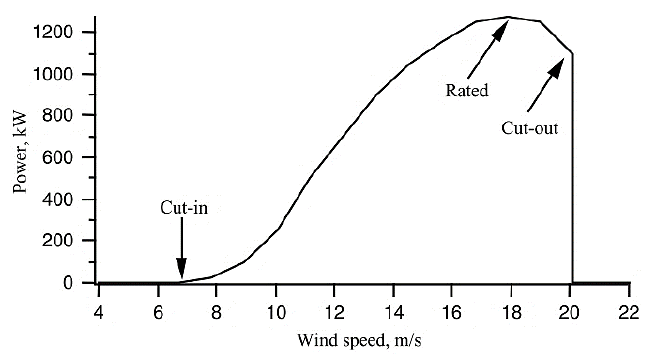
Figure 3. General wind turbine power curve.